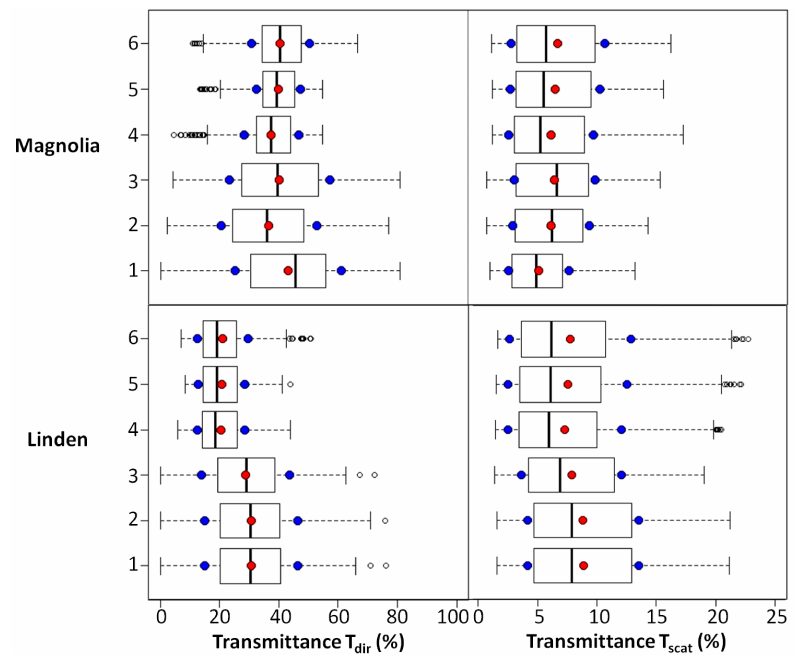
Figure 10. Boxplots of T dir and T scat representing their spatial variations computed within the tree shadow delineations at ground for the different tree models of the linden and magnolia trees at